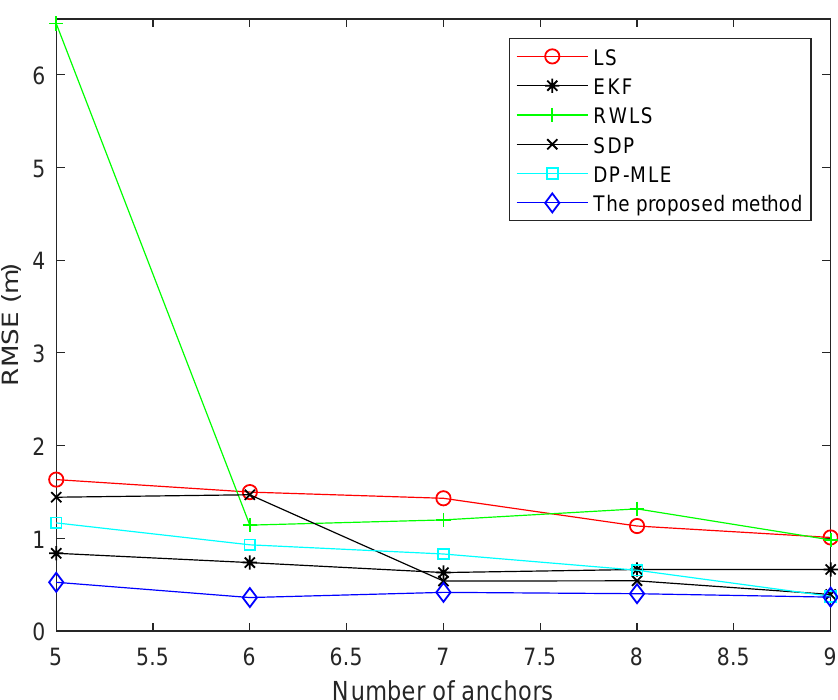
Figure 10. RMSEs of different algorithms using different numbers of